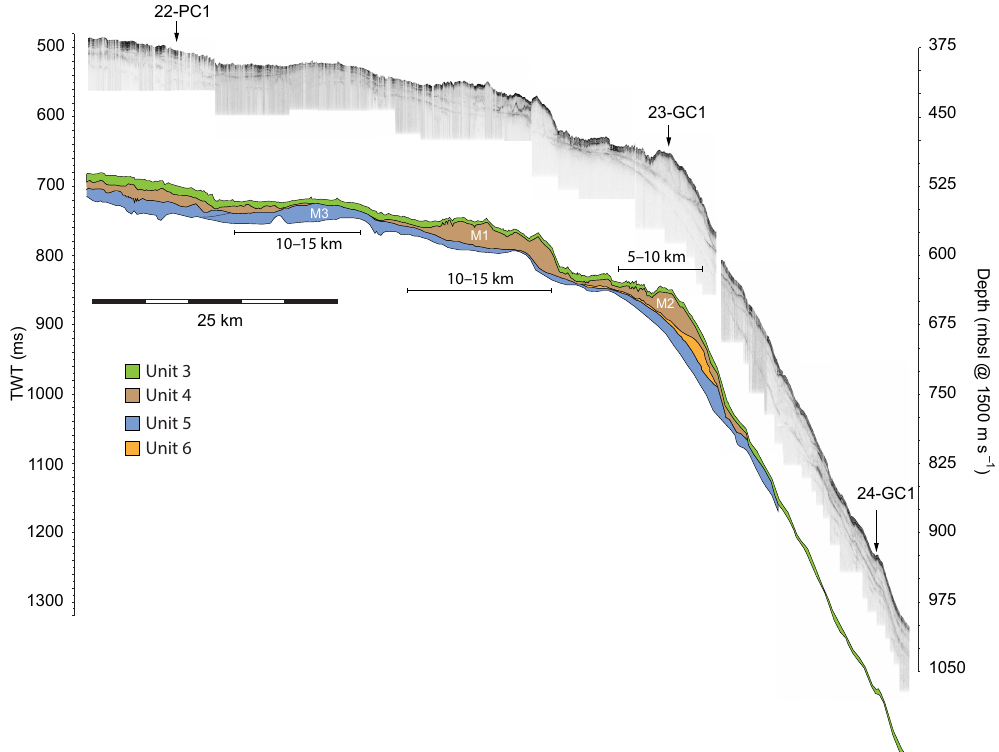
Figure 5. Location of sediment cores 22-PC1, 23-GC1 and 24-GC1 along the composite chirp sub-bottom profile. The interpreted profile is offset by 200msTWT from the true depth. The location of the profile is shown in Fig. 3. Table 2. Radiocarbon dates and calibrations from sediment cores 20-GC1, 23-GC1 and 24-GC1. All dates were calibrated with the Marine13 calibration curve (Reimer et al., 2013), with (cid:49)R = 50 ± 100 years for 20-GC1 (Cronin et al., 2017) and (cid:49)R = 0 years for 23-GC1 and 24- GC1. Cal 2 σ Cal 2 σ Median Lab ID Error Sample Mid-depth Material 14 C age max. age min.